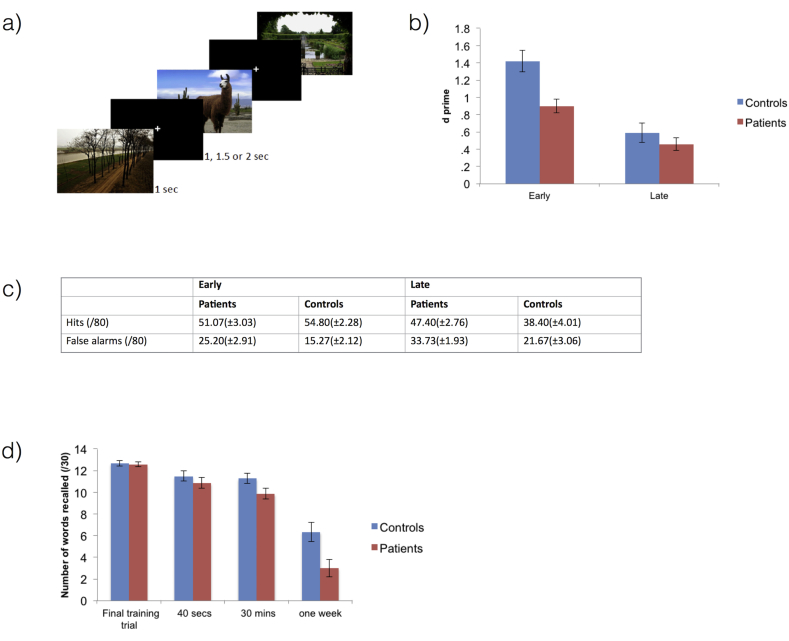
Task and behavioural results. (a) Three example stimuli from a novel block of the study task performed during the fMRI scan. Each image was presented for one second. There was an interval of varying duration (1, 1.5 or 2 s) between stimuli, during which a fixation cross was presented. The participant's task was to indicate, using an MR-compatible button box, whether each image contained an animal. The participant was also instructed to memorise the stimuli. (b) D′ in the Early and Late recognition memory tests of the fMRI task. The patients had a significantly lower d’ than the controls on the Early test, but not on the Late test. (c) The raw number of hits and false alarms in the Early and Late recognition tests. (d) Performance on the word-list recall task (RAVLT). The patients performed significantly more poorly than the controls on the 1-week test and the 30-min test, but not on the final training trial or the 40-s test. The percentage forgotten between the 30-min test and the 1-week test was significantly greater in the patients than the controls. The error bars represent SEMs.